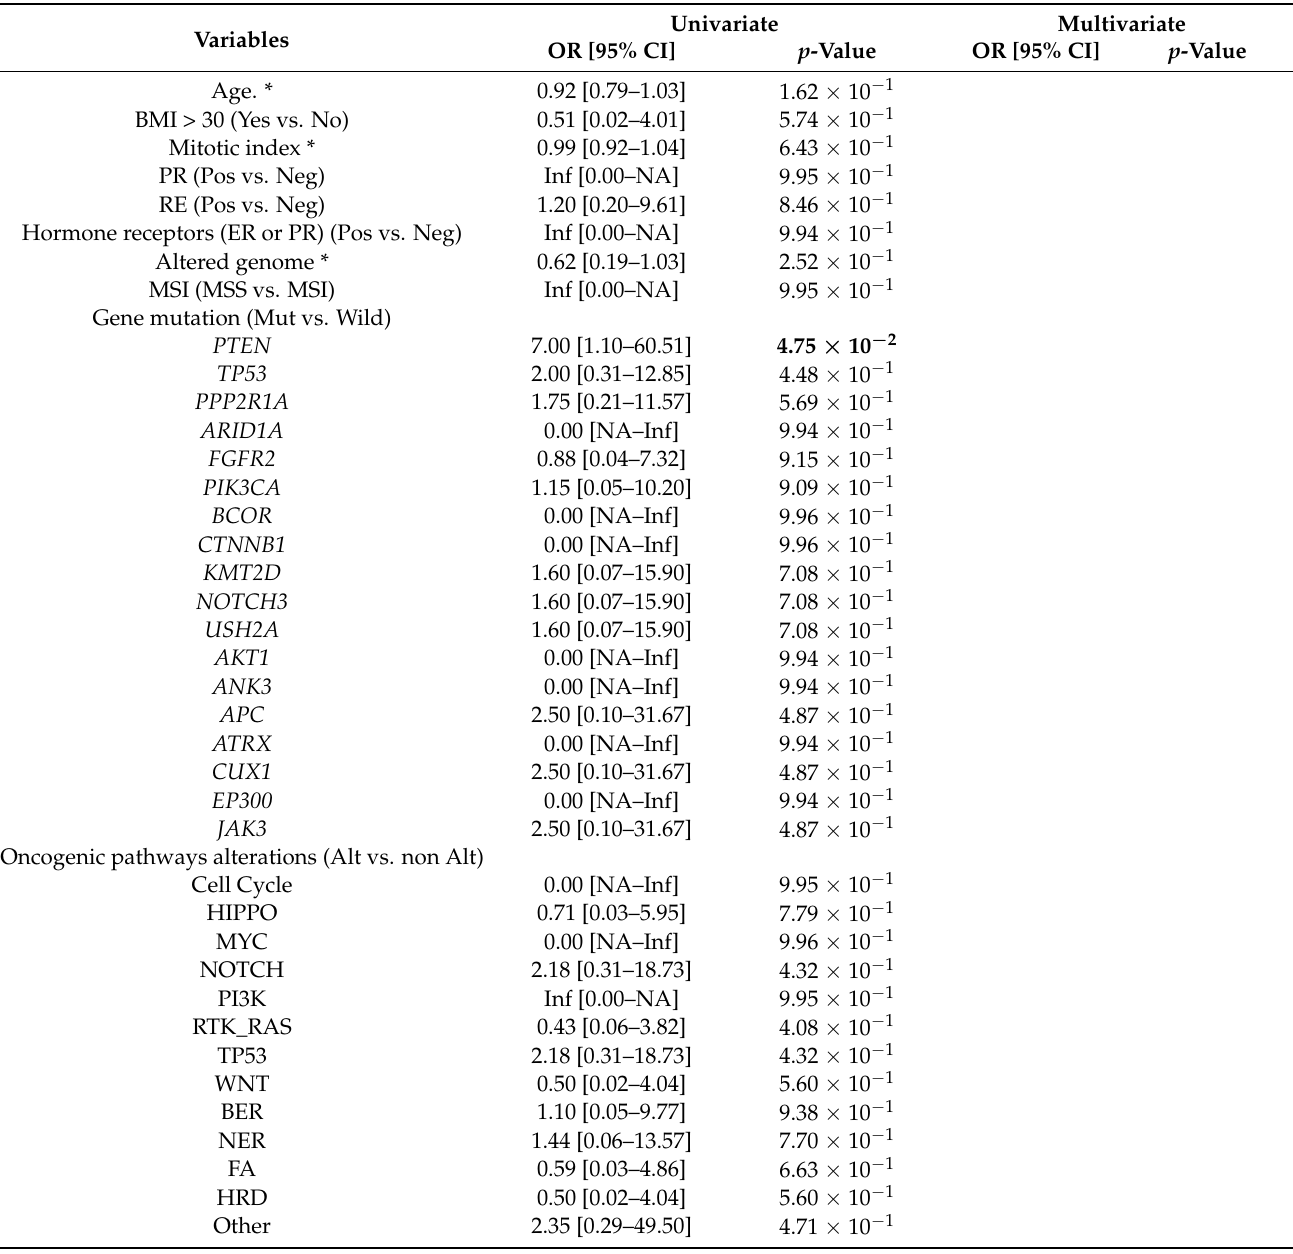
Table 3. Results of univariate and multivariate analysis for